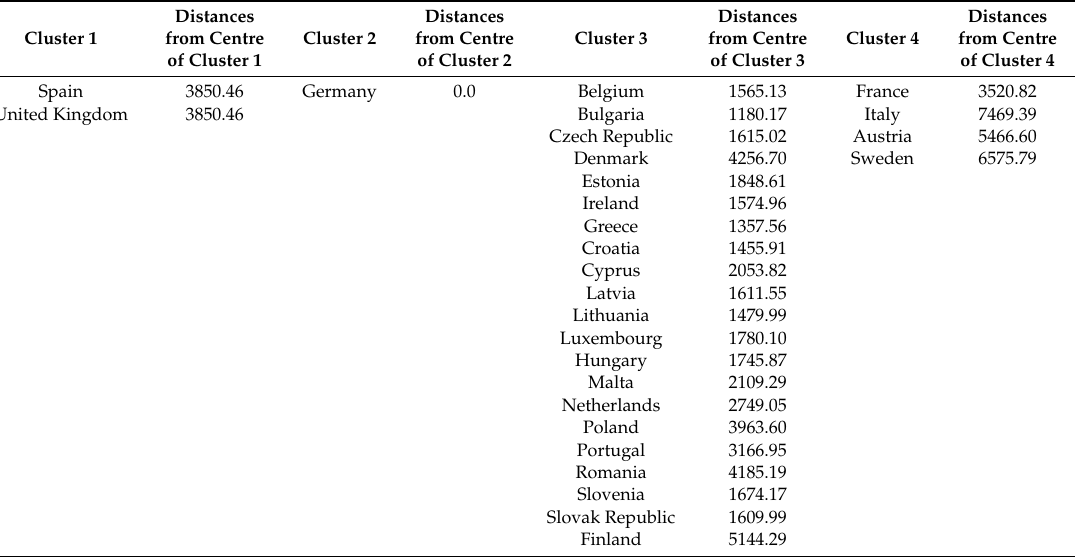
Table 14. Elements of clusters with distances from centers (own